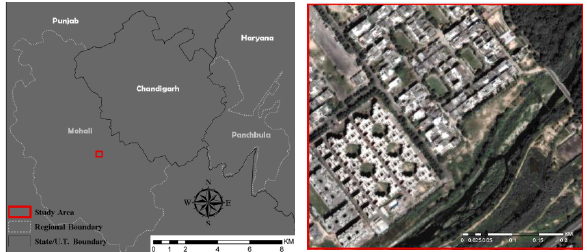
Figure 4. Key map of Study Area Figure 5. Pleiades pan- sharpened data for target